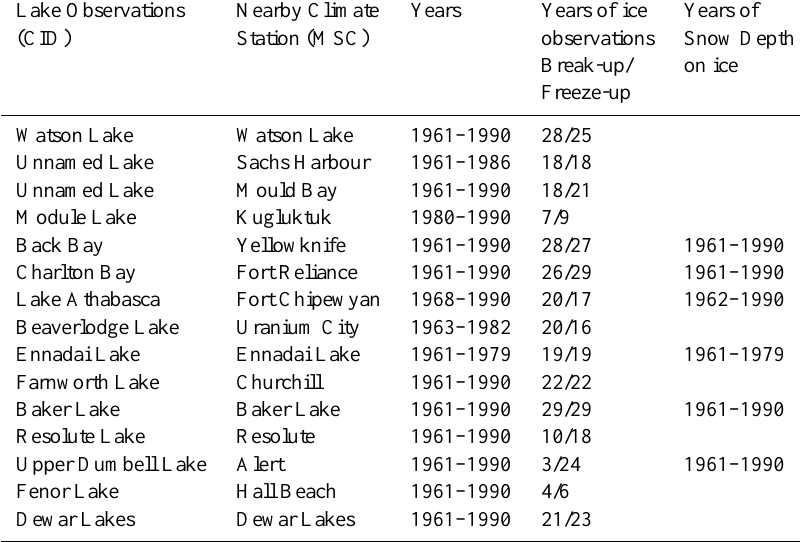
Table 1. Summary of the lake ice observation data, corresponding climate station and the years used.